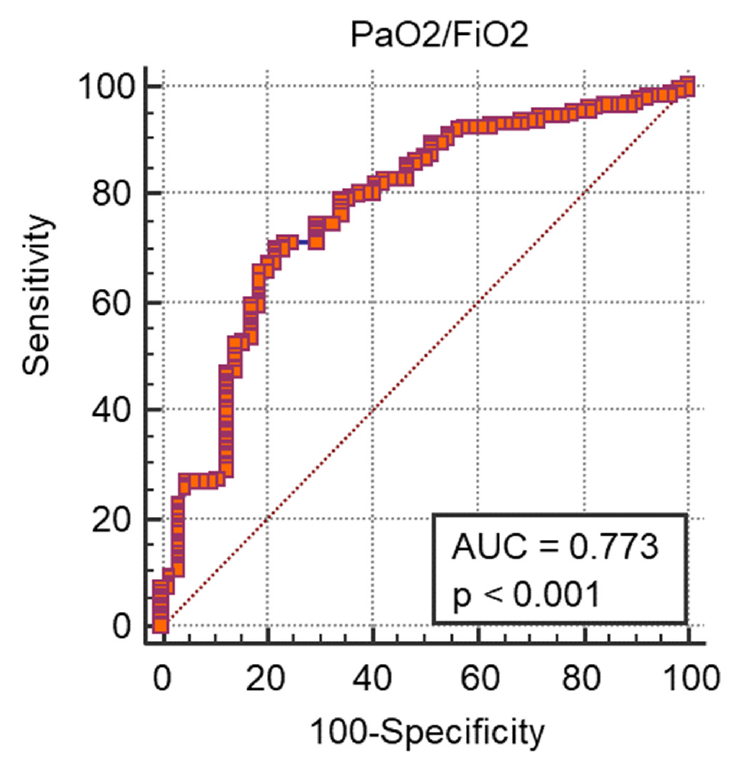
Figure 2. ROC curve e AUC values for PaO2/FiO2 and ICU admission.